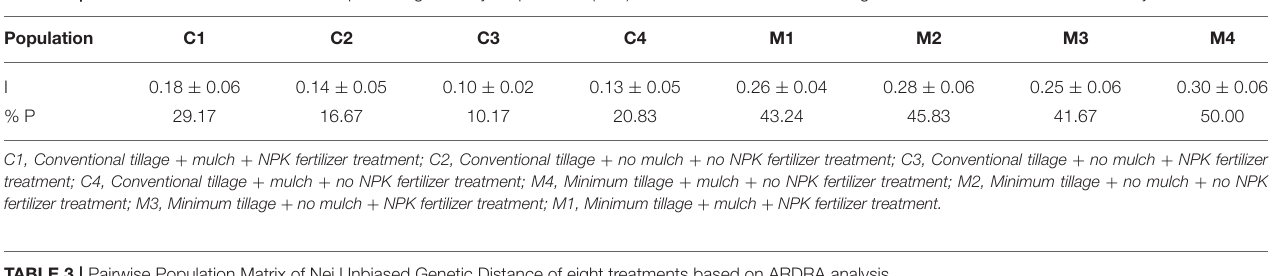
TABLE 3 | Pairwise Population Matrix of Nei Unbiased Genetic Distance of eight treatments based on ARDRA analysis. C1 C2 C3 C4 M4 M2 M3 M1 C1 0.000